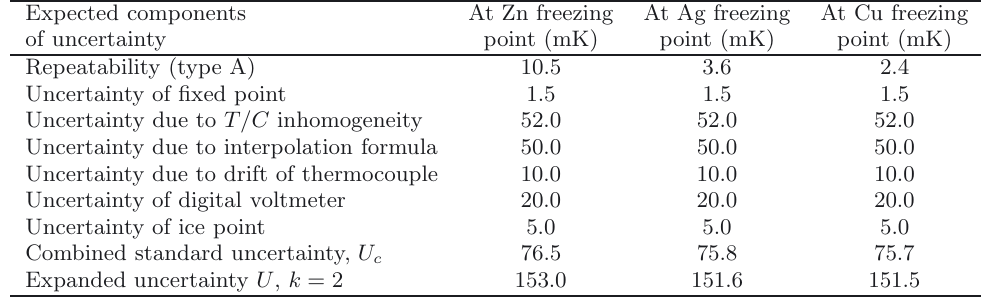
Table 3. The combined uncertainty U c expressed in the form of 95% confidence level for the calibration of Pt/Pd thermocouples in Zn and Ag and Cu freezing points is estimated.